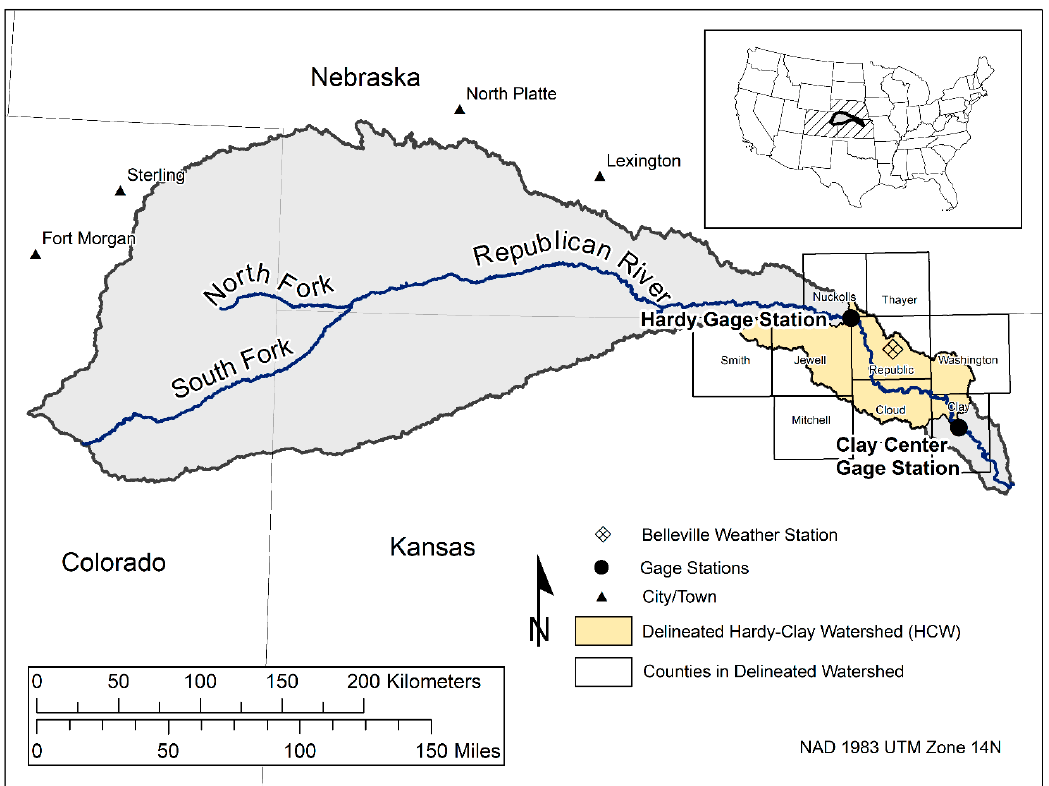
Figure 1. The Republican River Basin with the delineated watershed between the Hardy and Clay Center gage stations, the Hardy-Clay Watershed (HCW). Also shown is the location of the Belleville weather station, and the boundary of the counties that contain part of the HCW.